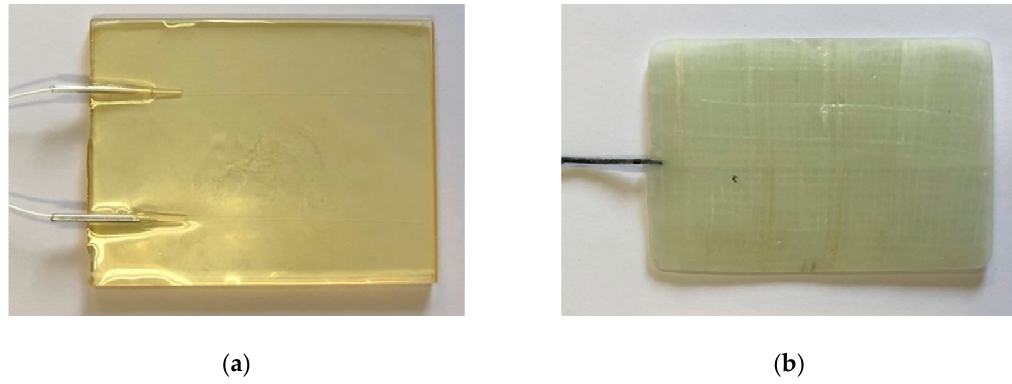
Figure 3. (a) Epoxy and (b) GFRP sample with embedded OFSs on the left-hand side.